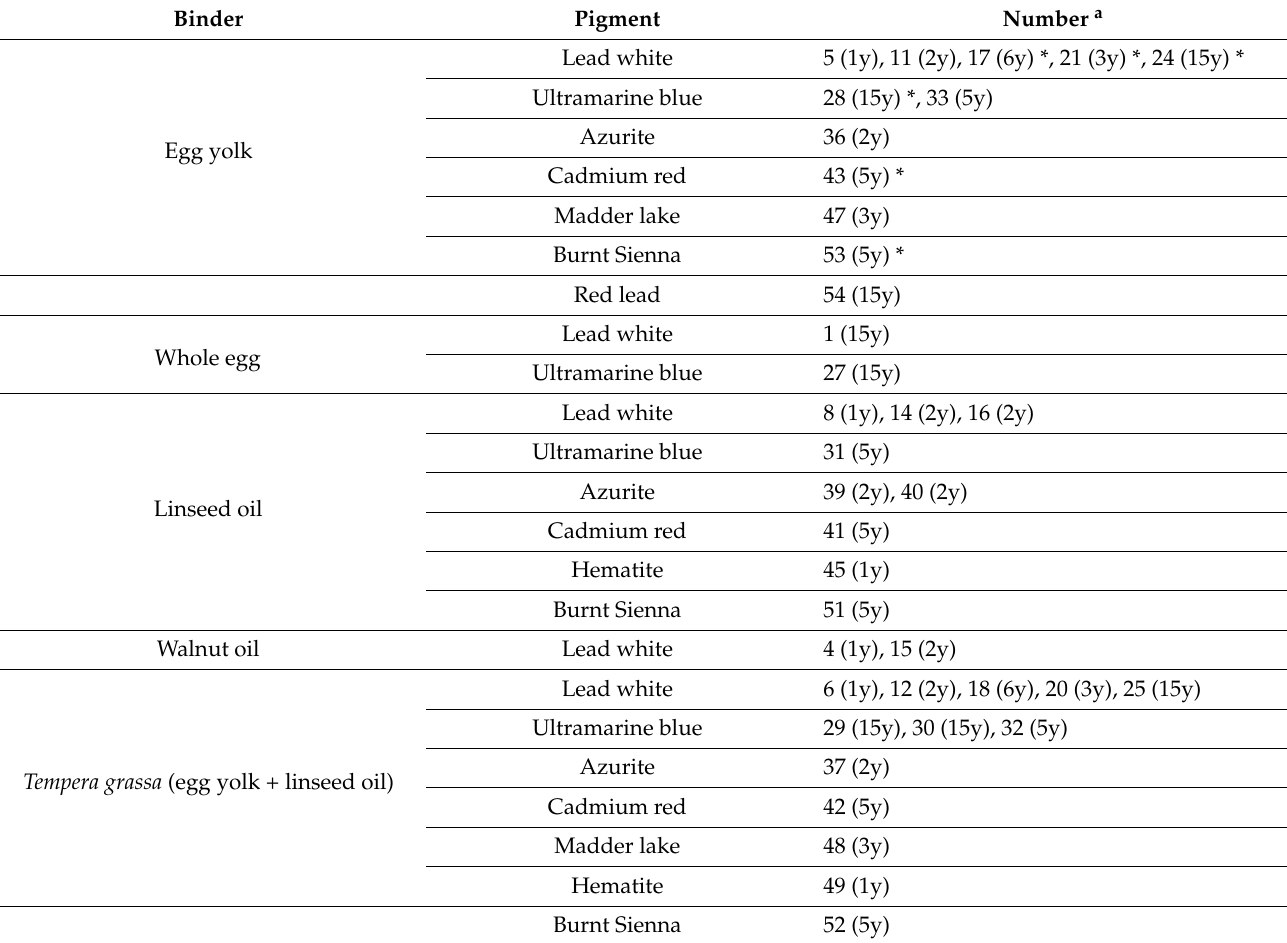
Table 1. List of the pigments and binders in each of the model painting samples examined. The age of the sample in years (y) is indicated in brackets next to the identification